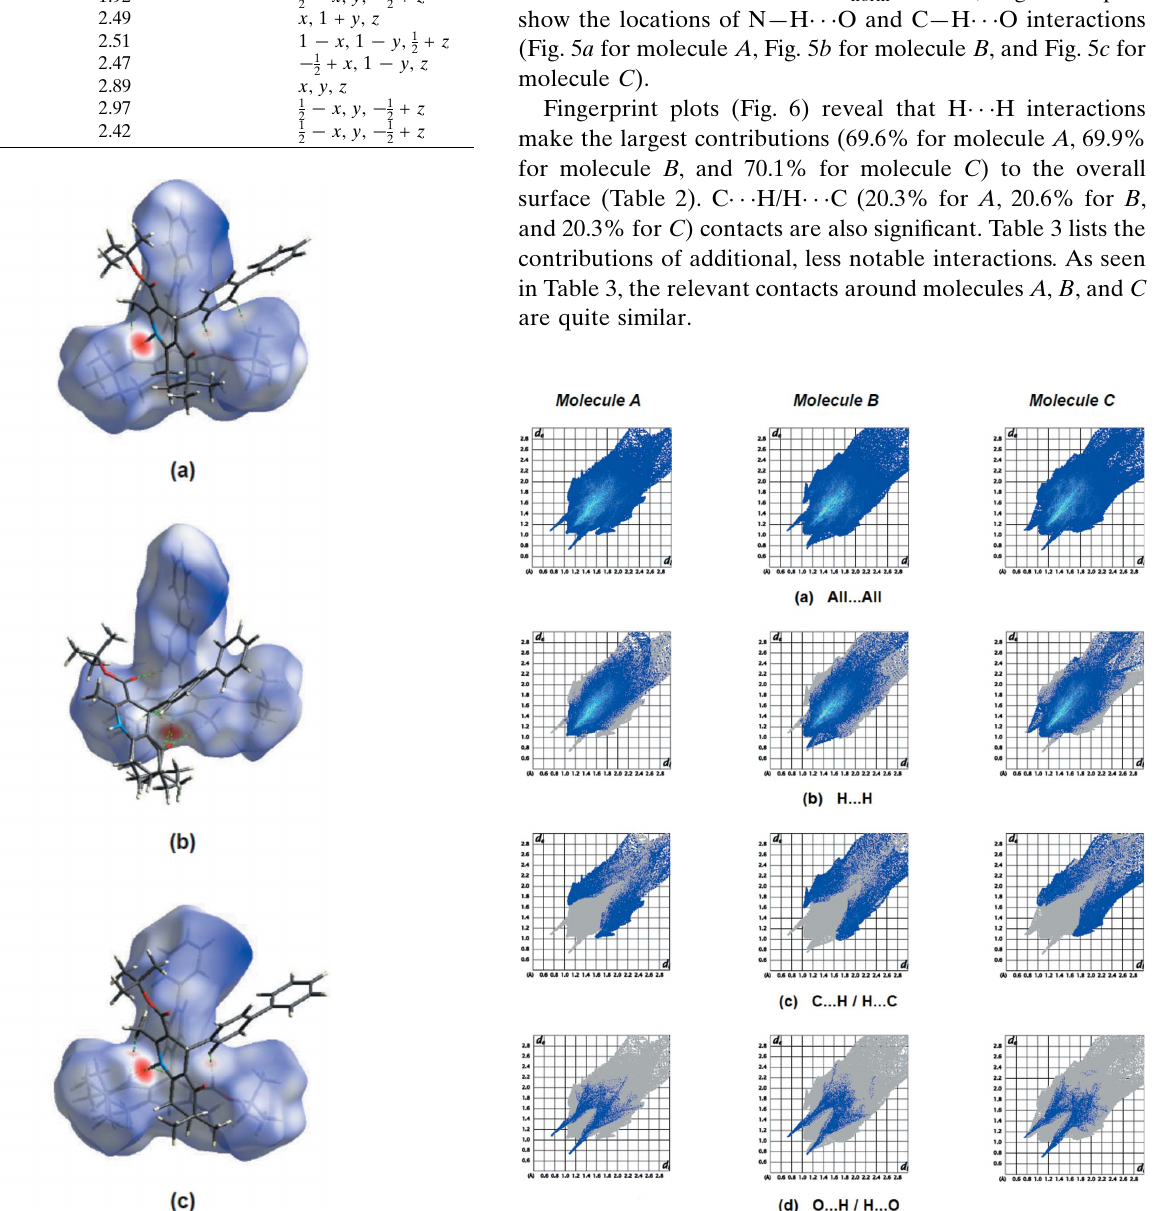
(Fig. 5 a for molecule A , Fig. 5 b for molecule B , and Fig. 5 c for molecule C ).